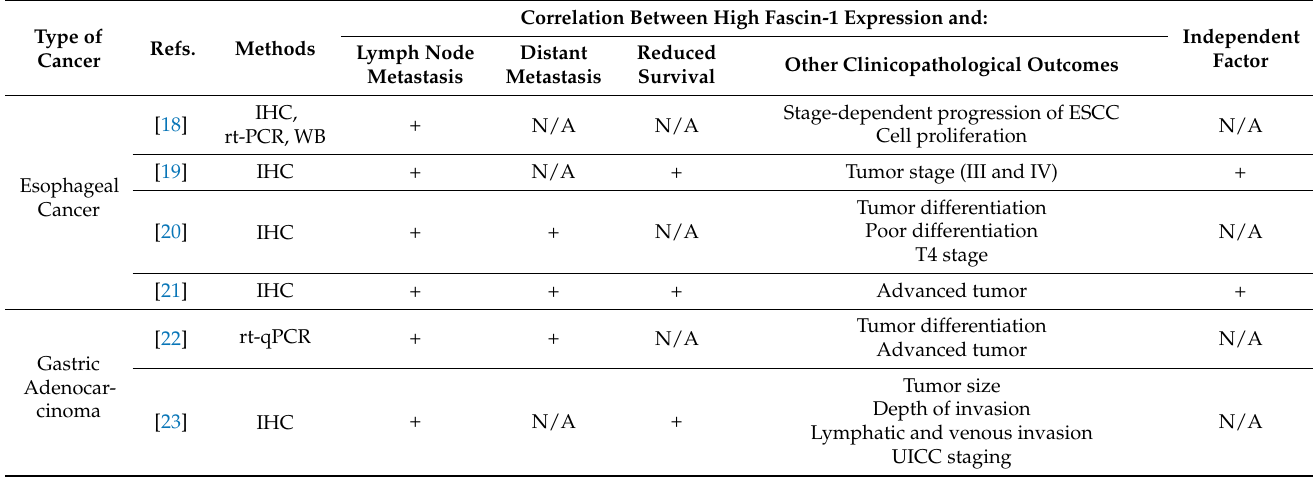
Table 1. Overexpression pattern of fascin-1 in GI tract cancers as an unfavorable prognostic and diagnostic marker for advanced carcinogenesis, regional and distant metastases, and overall survival. Type of Cancer Refs.